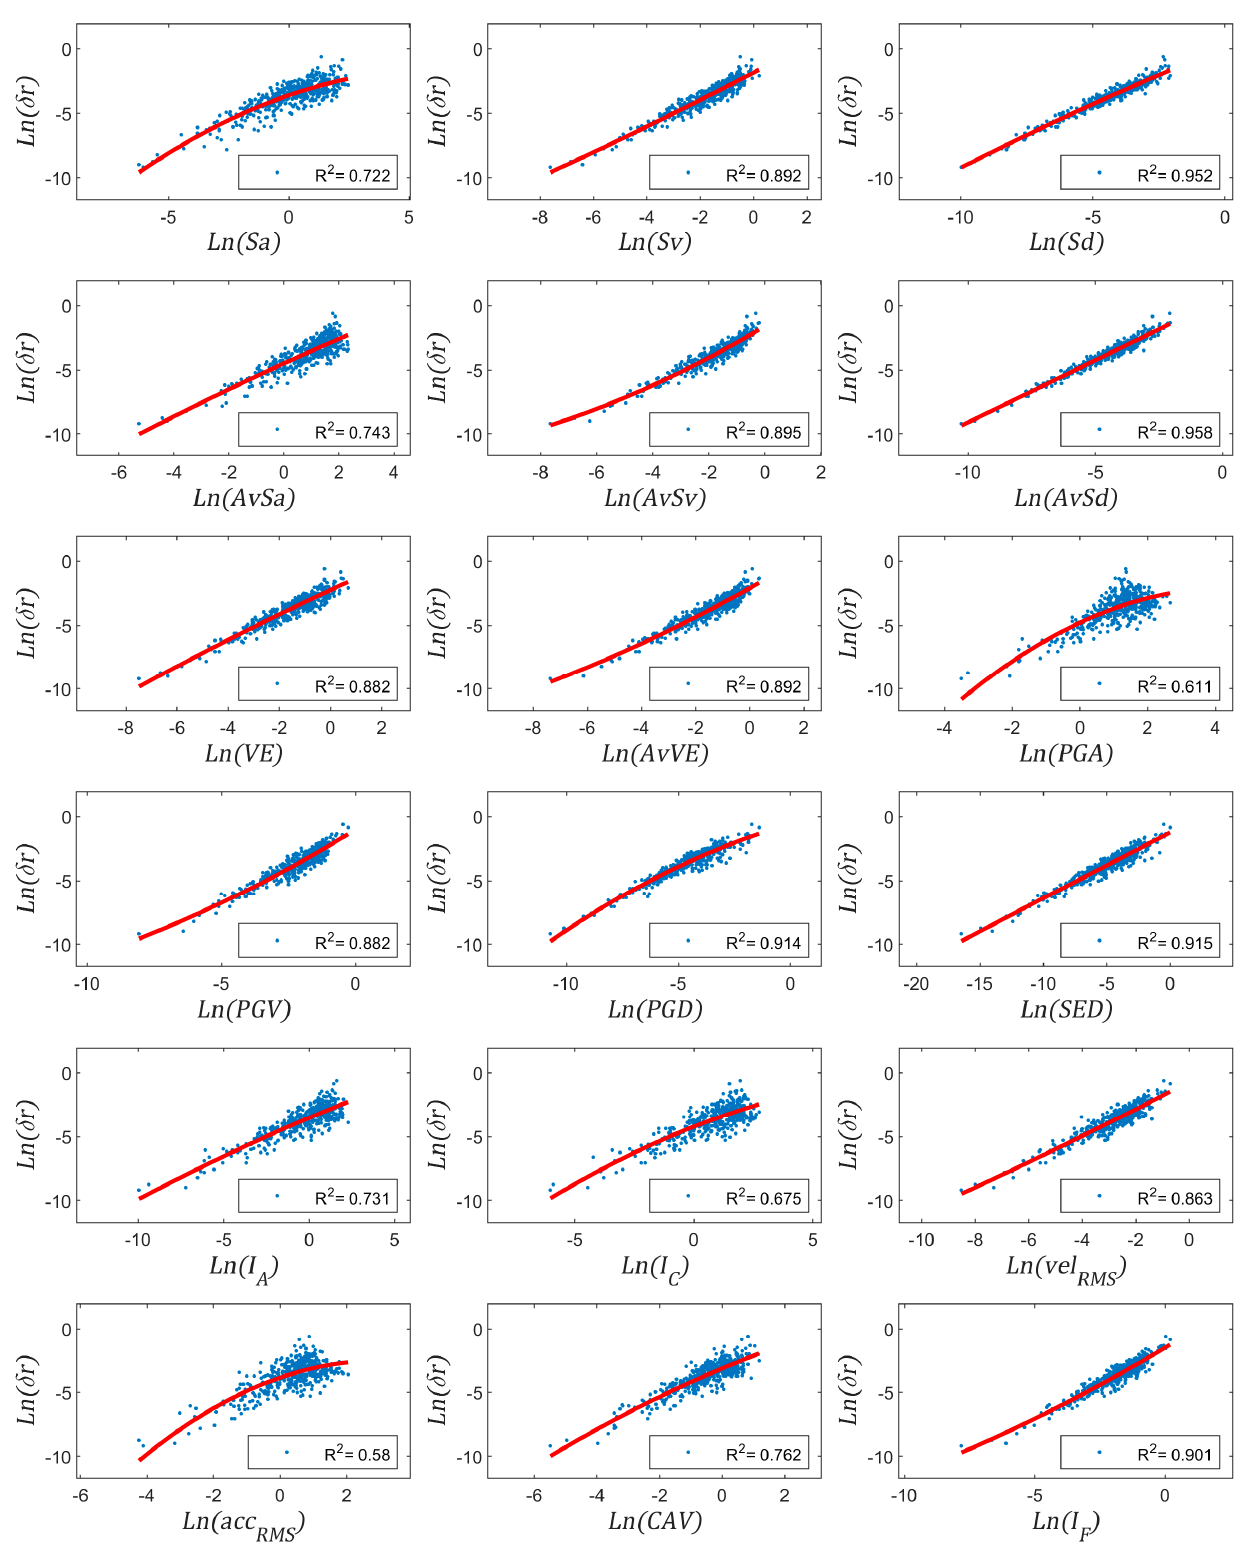
Figure 4. Correlation coefficient between IMs and δr in the log-log space for near-fault records.